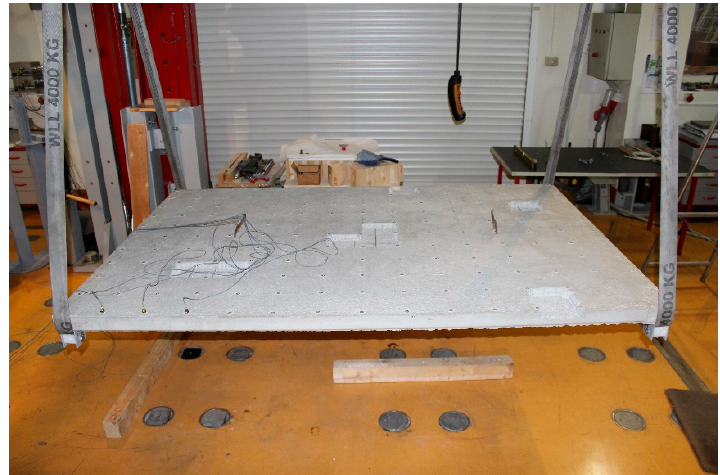
Figure 2. Suspended plate with discrete damages.